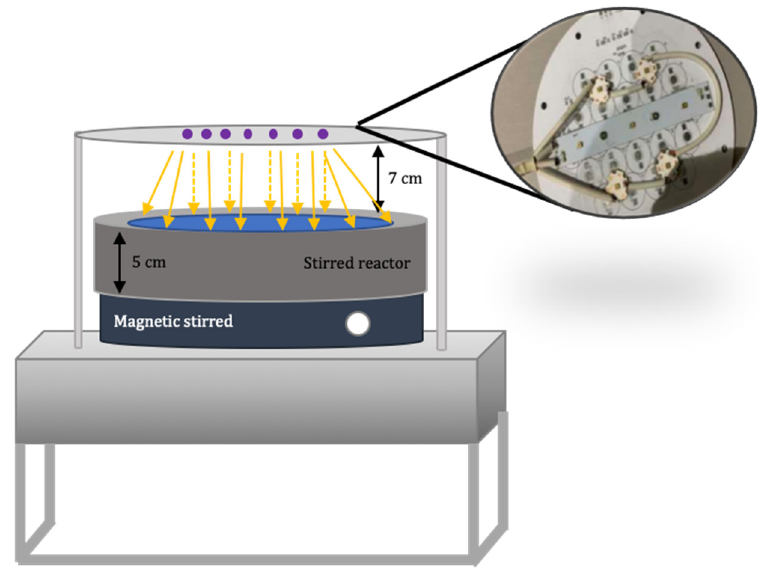
Figure 1. Design of the experimental UVC-LED device.